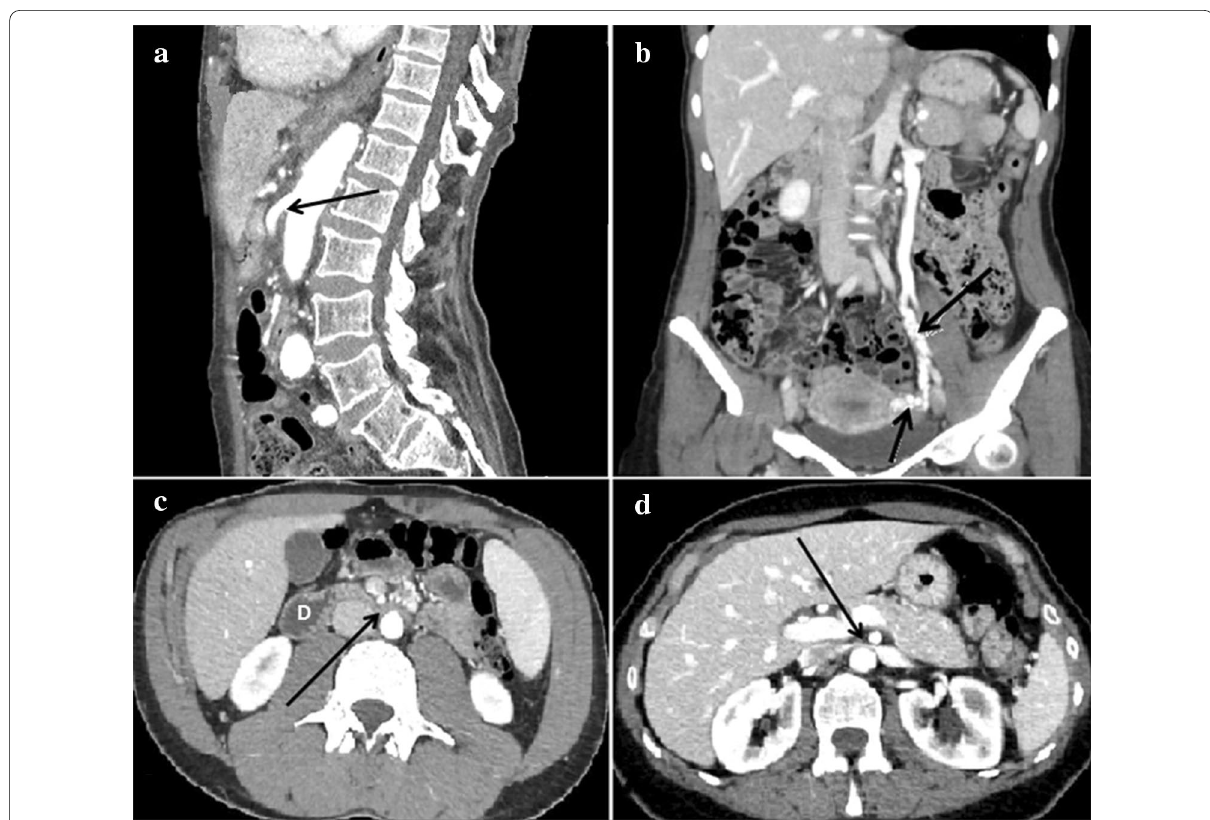
Fig. 8 Abdomen MDCT examination. a The reconstruction according to a sagittal plane shows the characteristic pattern with aorta and superior mesenteric artery "beak-like" appearance (black arrow). b The coronal plane reconstruction shows dilation of the gonadal vein and gonadal plexus (arrow). c The axial plane reconstruction shows a stenosis of duodenum (arrow). "D": Duodenum. d The axial plane reconstruction shows a stenosis of the left renal vein